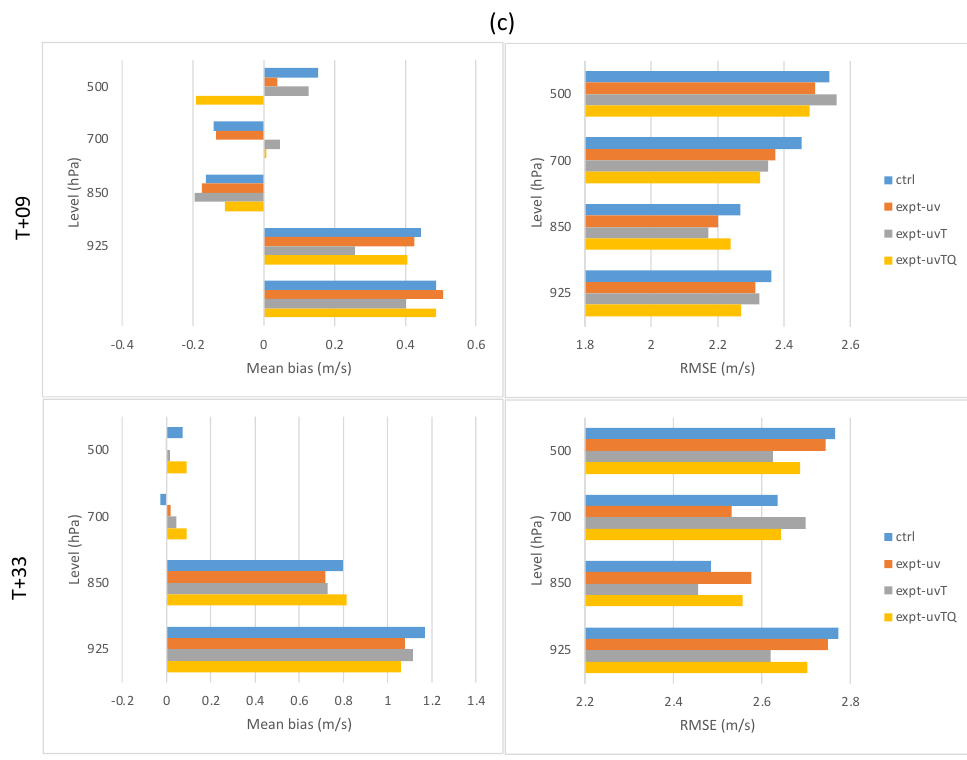
Figure 6. Mean error statistics: ( a ) relative humidity (RH), ( b ) temperature (T), and ( c ) meridional wind (v) estimated against all stations in the domain are shown for 03Z and 15Z cycles at the indicated levels.